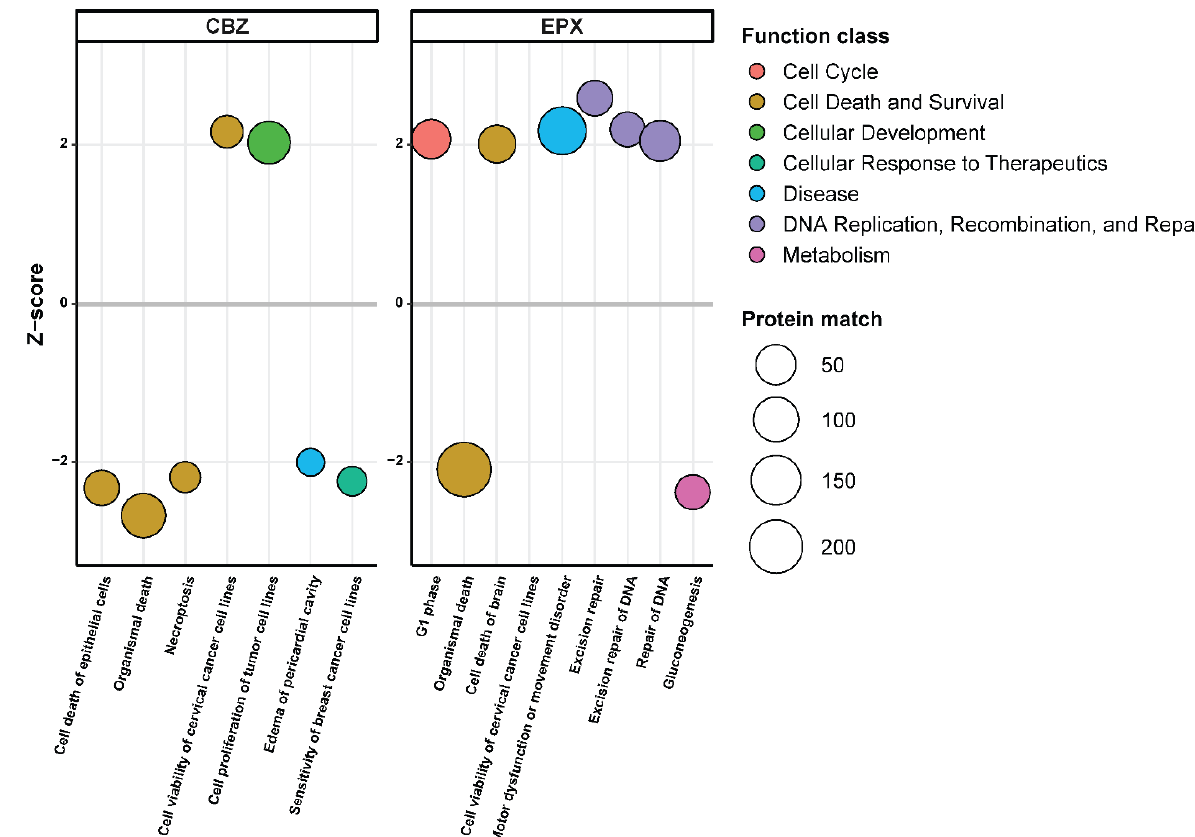
Figure 4. IPA disease and function analysis of proteomic changes induced by EPX or CBZ treatment in LCL721.221/mHLA-B*57:01 cells vs. parental LCL721.221 cells. Only functions are depicted that were predicted to be up- or downregulated (Z-score > 2 or < − 2) by the IPA software.